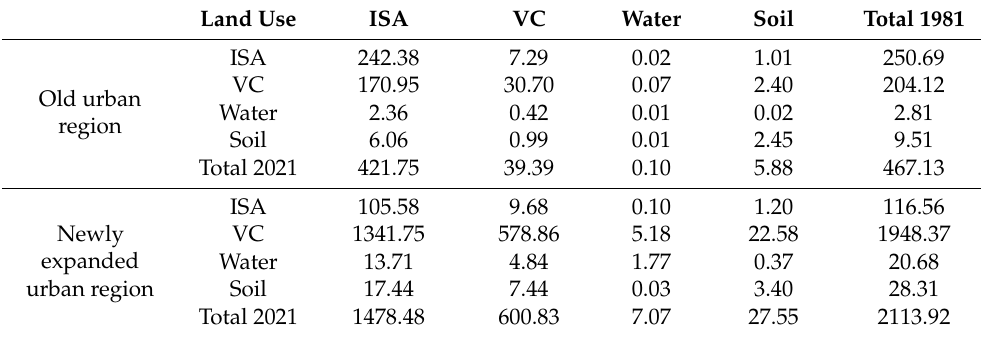
Table 5. Urban land trajectory transformations in different urbanized regions (Area unit: km 2